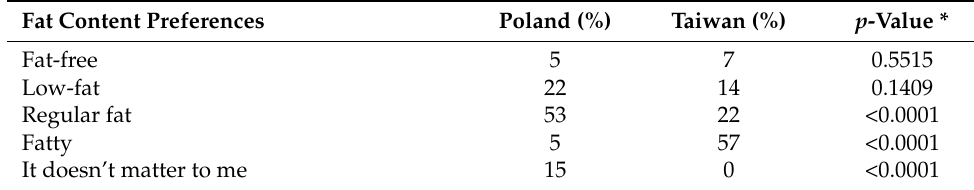
Table 4. Preferences for fat content in